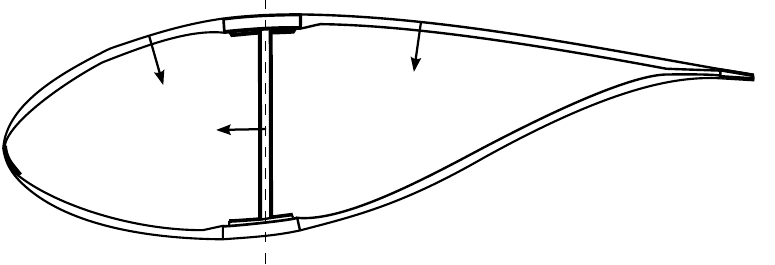
Figure 6. Reference planes and stacking directions.